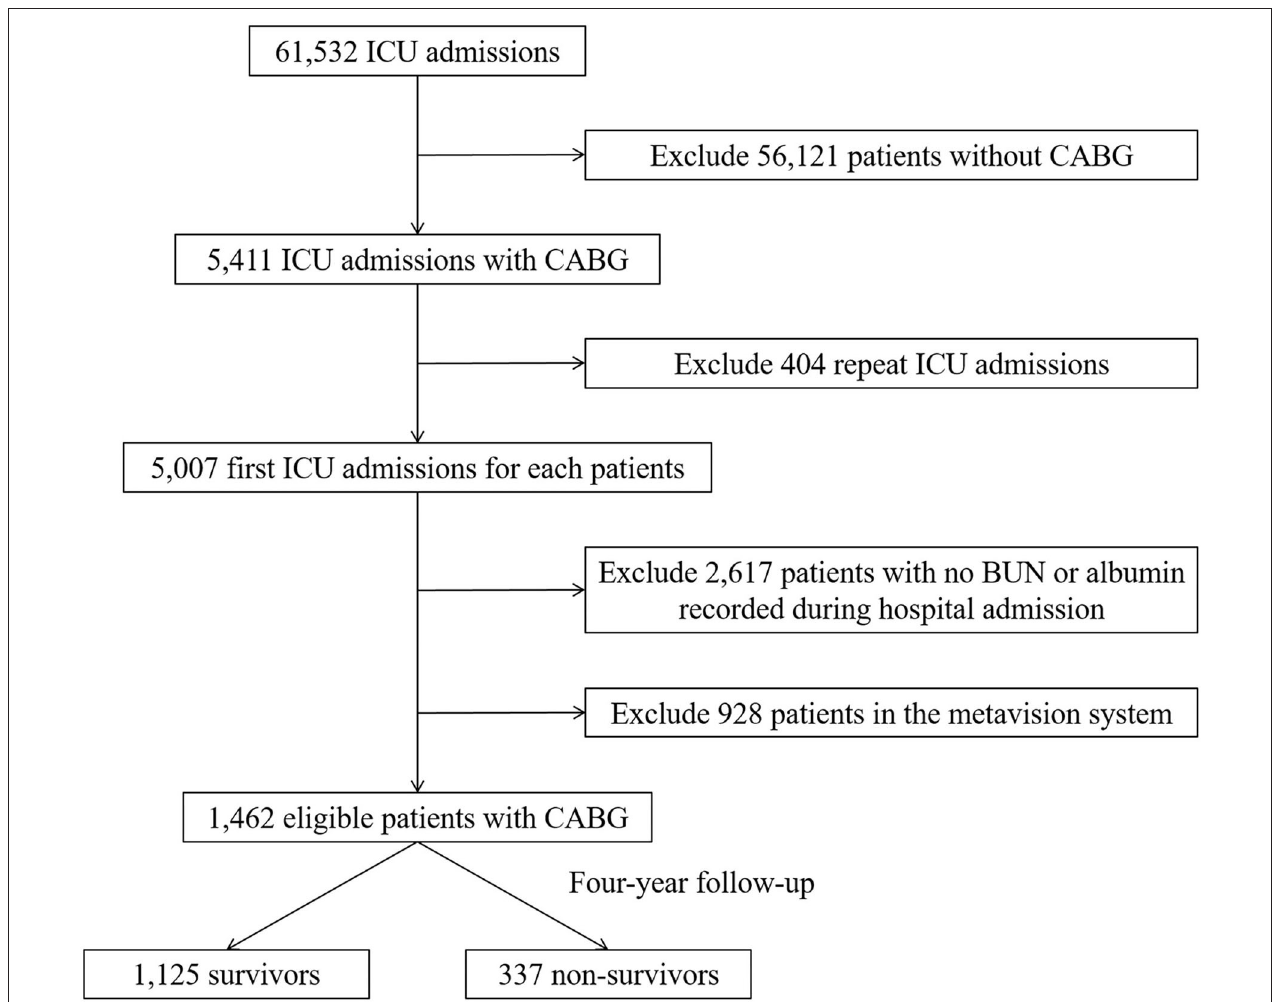
FIGURE 1 | Flow diagram of study patient selection. ICU, intensive care unit; CABG, coronary artery bypass grafting; BUN, blood urea